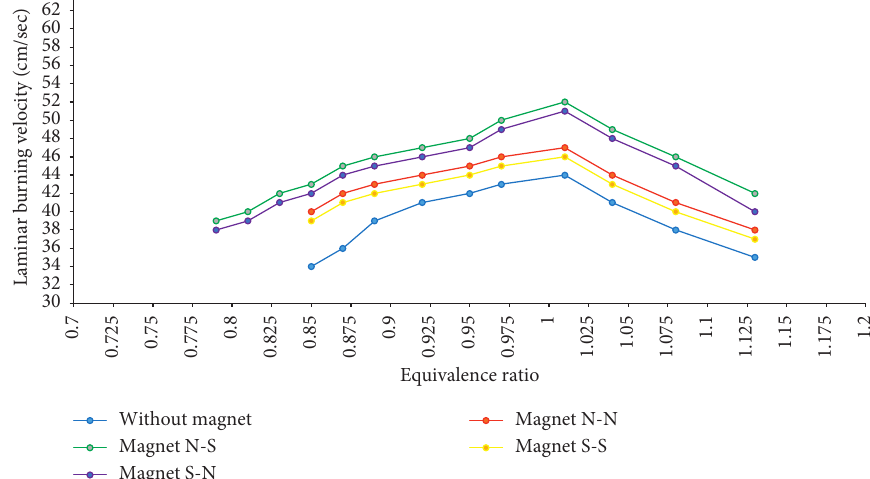
Figure 7: Laminar burning velocity of jatropha oil versus equivalence ratio at various magnetic field orientations and without magnetic field.